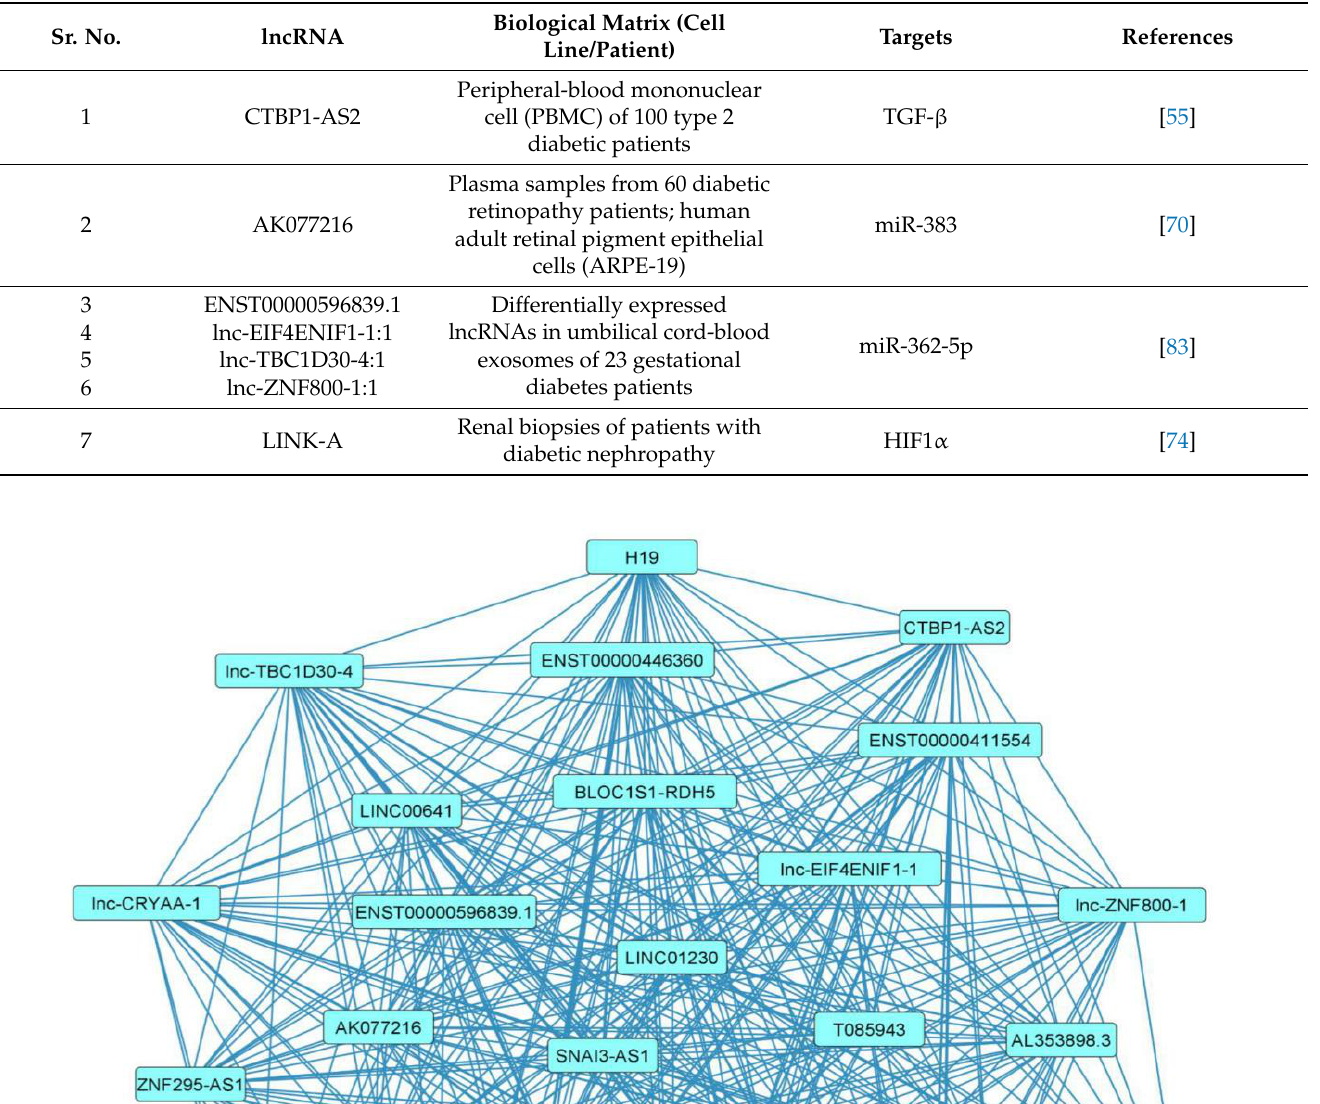
Table 4. Downregulated human lncRNAs in diabetes.